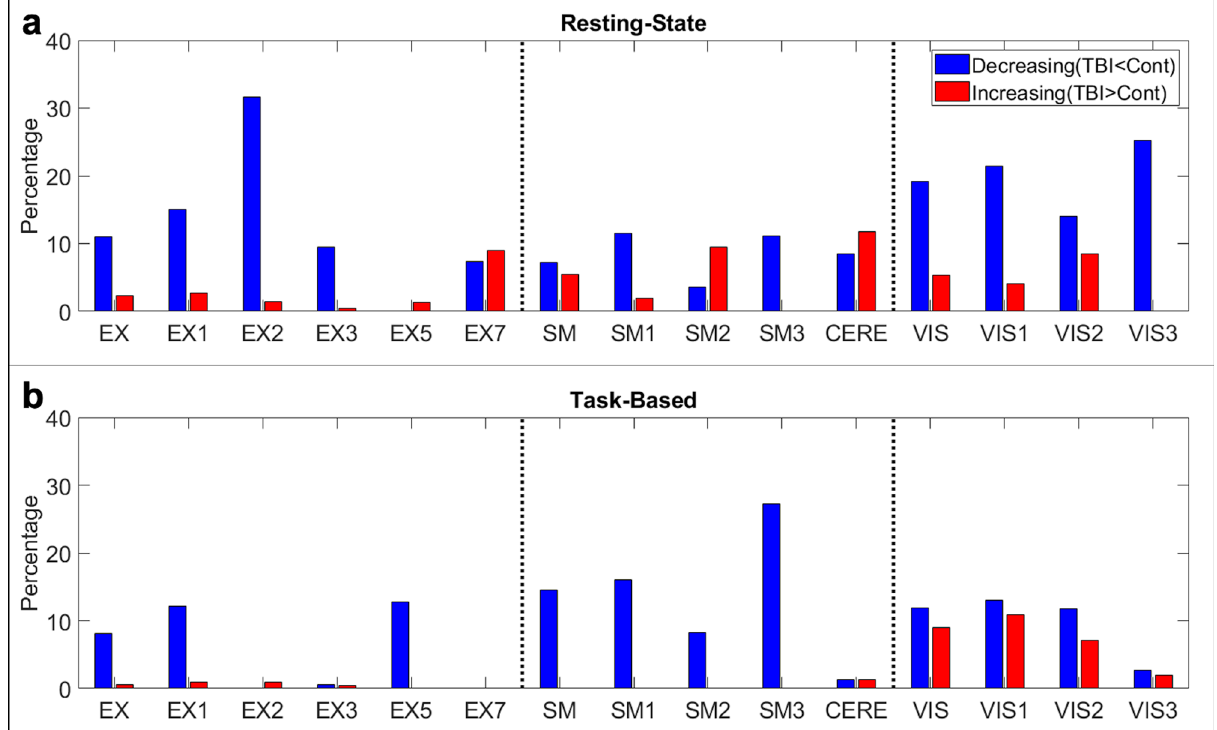
Figure 7. Permutation analysis percentages of significantly different voxels. Bar plots of the percentages of significantly decreasing (blue, TBI < Control) and increasing (red, TBI > Control) voxels contained within each network and each individual anatomical region comprising each network for the resting-state ( a ) and task-based ( b ) fMRI permutation analysis. Abbreviations: visual (VIS), executive control (EX), sensorimotor (SM), and cerebellar (CERE). Regions EX4 and EX6, corresponding to the orbitofrontal and ventral anterior cingulate cortices, are not shown, as they did not contain any significantly different voxels for either analysis. For identification of other regions, refer to Table 1.